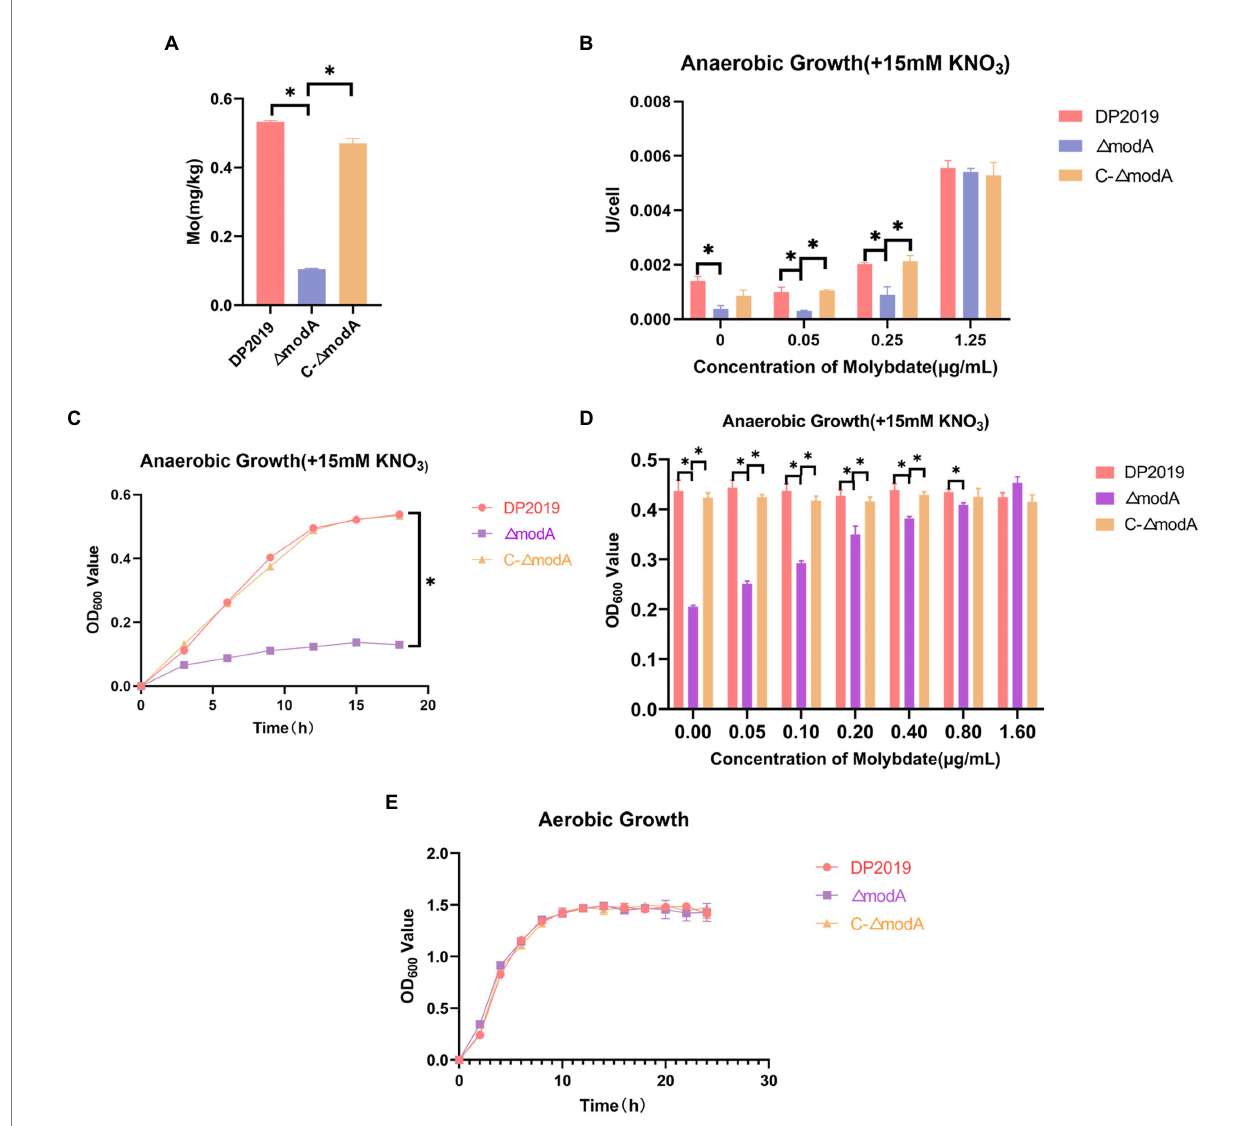
FIGURE 1 ModA affects bacterial transport of molybdate to synthesize molybdoenzymes and thus participates in anaerobic respiration. (A) Bacterial intracellular molybdenum content. (B) Under anaerobic conditions, 15 mM KNO 3 was added to the culture medium, and the nitrate reductase activity was measured at different molybdate concentrations. (C) Anaerobic growth curve of bacteria when 15 mM KNO 3 was added to the culture medium. (D) Anaerobic growth for 12h at different molybdate concentrations in medium supplemented with 15 mM KNO 3 . (E) Aerobic growth curve of bacteria after the addition of 15 mM KNO 3 to the culture medium. Data are presented as the mean ± S.D. of three independent experiments, * p <